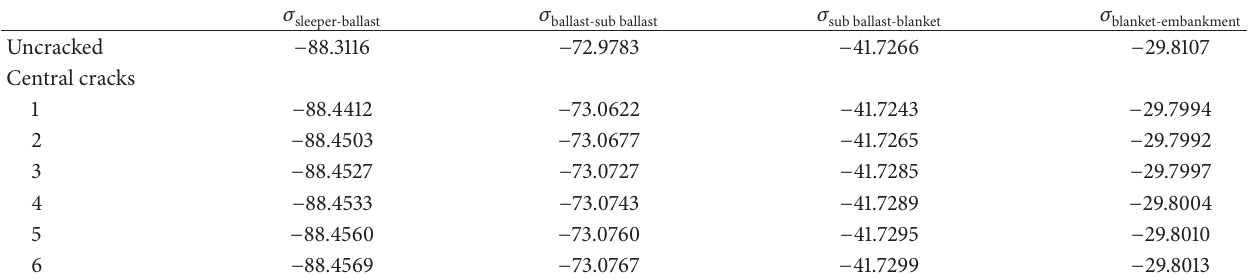
Table 7: Stresses (KPa) in the track model with 1 to 6 central cracks.